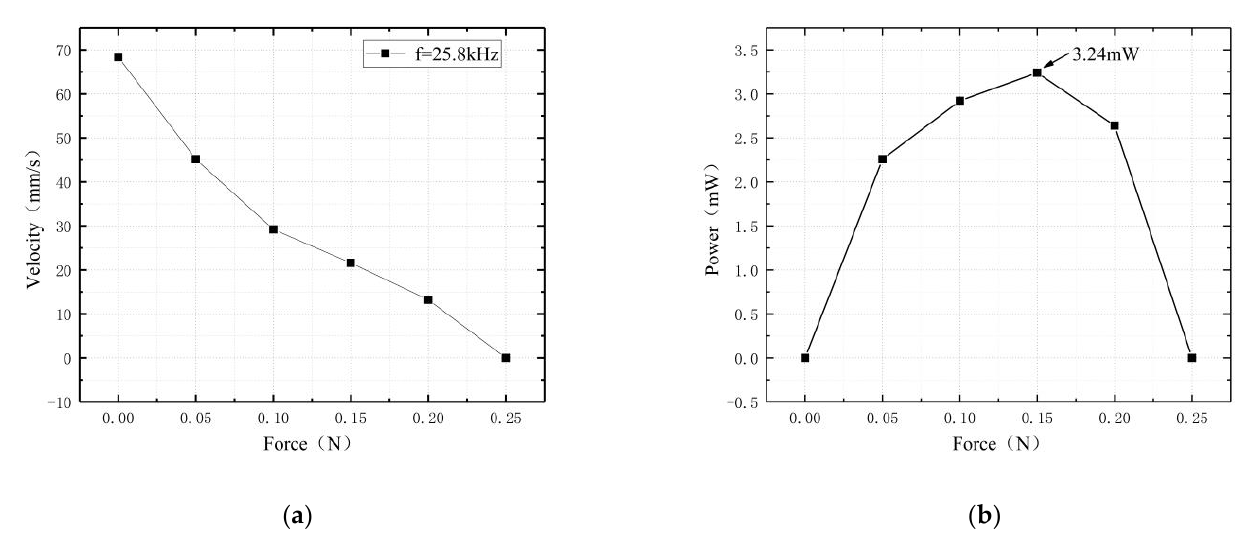
Figure 15. Mechanical characteristics: ( a ) the relationship between force and velocity; ( b ) the relationship between force and power.